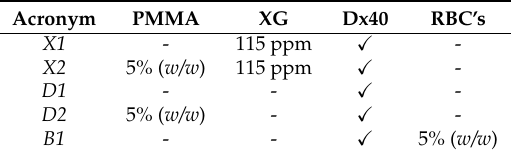
Table 1. Composition of the working